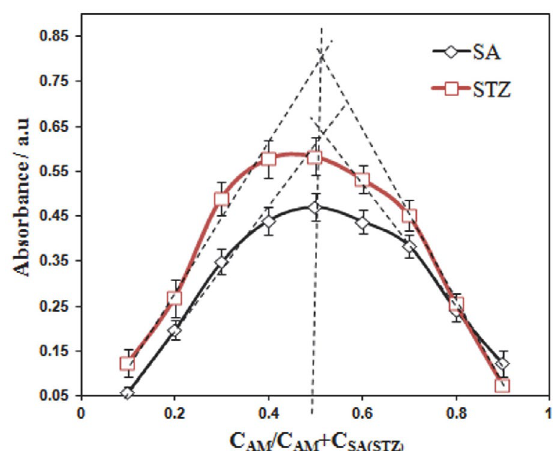
Fig. 8. The method of continuous varations. 1. C SA + C AM = 3.12 . 10 –4 M, C HCl = 0.6 M; 2. C STZ + C AM = 3.12 . 10 –4 M, C HCl = 0.7 M;